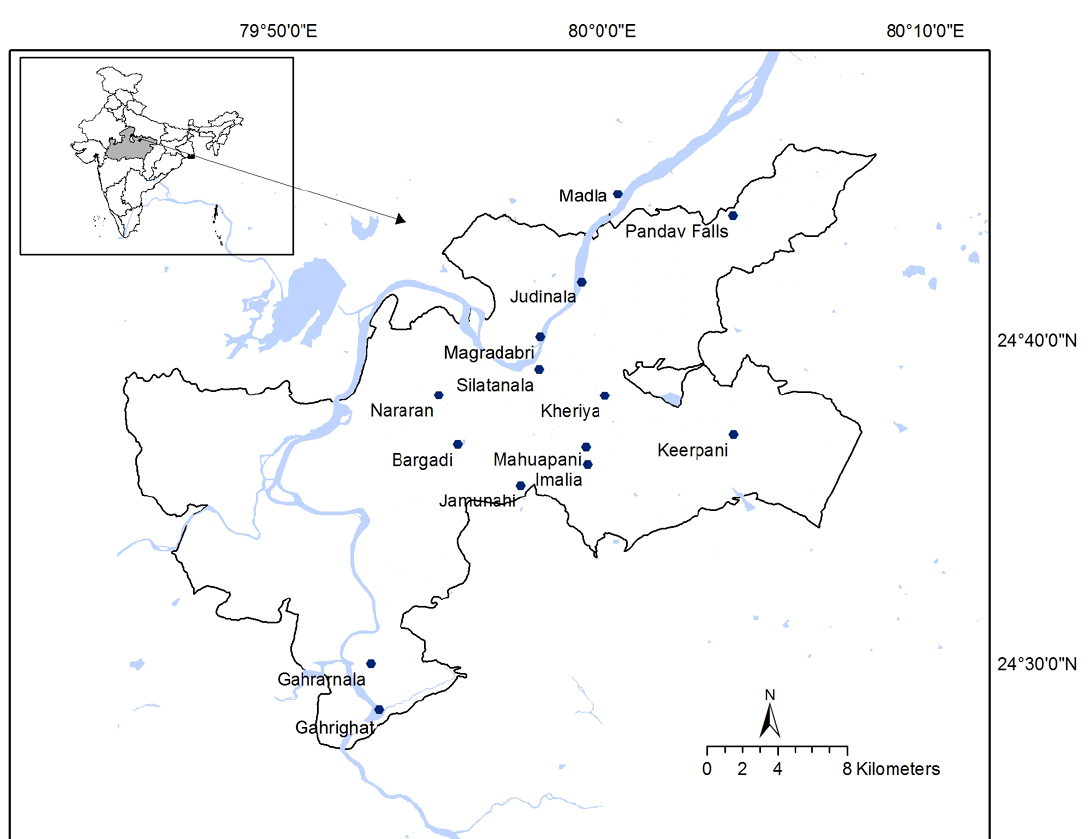
Figure 1. Sampling sites in Panna landscape, Madhya Pradesh.